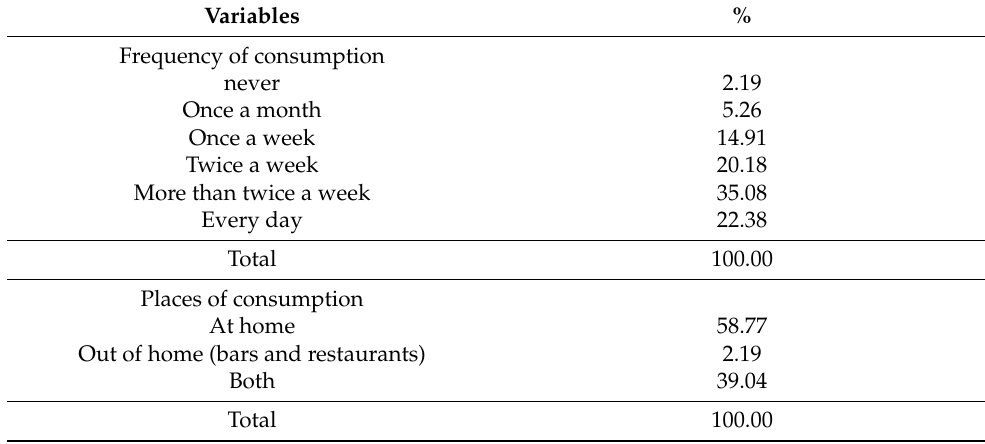
Table 2. Frequency of durum wheat pasta consumption and places of consumption.